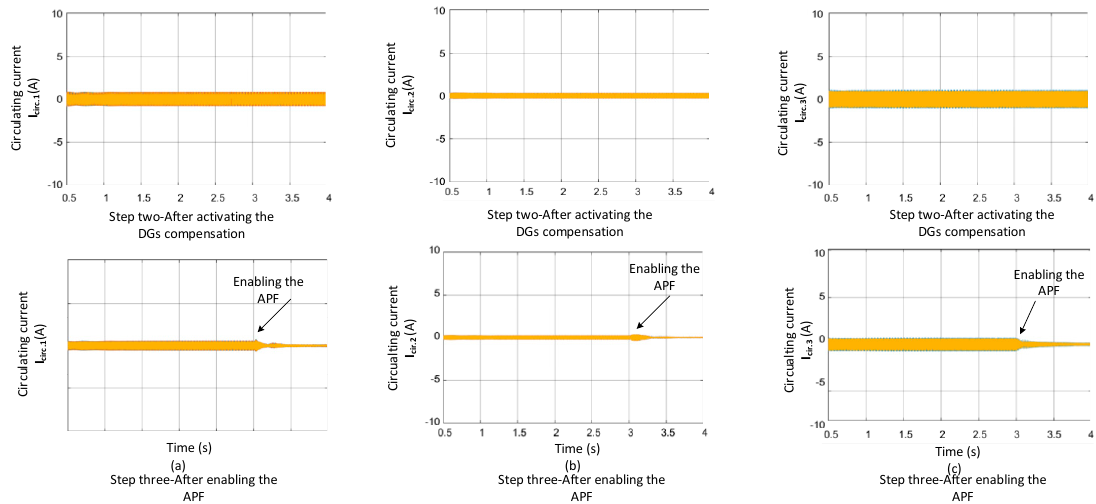
Figure 10. Reduction in circulating current waveforms of DGs.